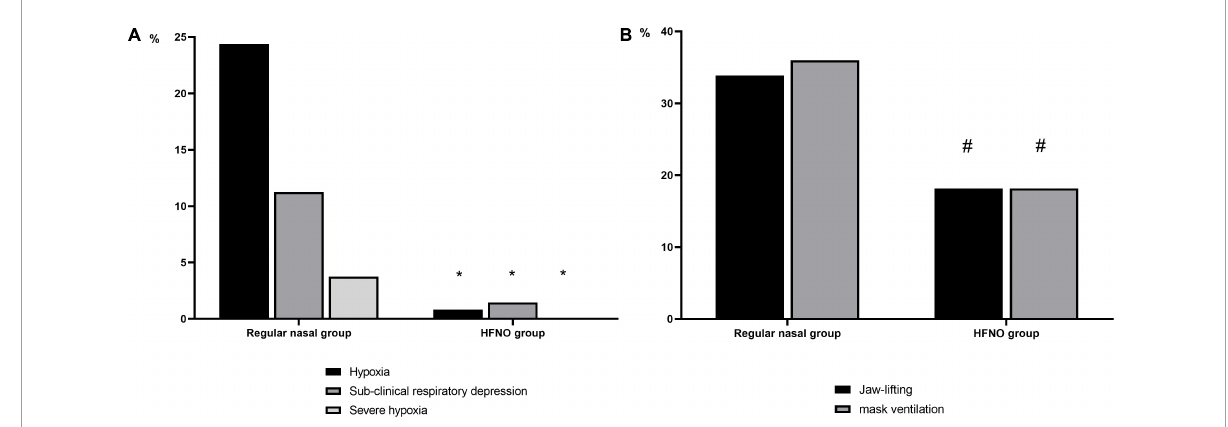
FIGURE3 Incidence of hypoxia events and their interventions. (A) Incidence of hypoxia events in both groups. Compared with the regular nasal group, HFNO significantly decreased the incidence of hypoxia (75% ≤ SpO2 < 90%, < 60 s), subclinical respiratory depression (90% ≤ SpO 2 < 95%) and severe hypoxia (SpO 2 < 75% for any duration or 75% ≤ SpO 2 < 90% for ≥ 60 s) from 24.38 to 0.83%, from 11.25 to 1.46% and from 3.75 to 0% (* P < 0.001, respectively). (B) Interventions during hypoxia. Compared with the regular nasal group, lower proportion in the HFNO group required oxygen improvement by jaw lifting or mask ventilation. In the regular nasal group, 132 patients needed their airway opened to relieve hypoxia, accounting for approximately 70% (69.84%) of the 189 patients; of these, 64 (33.86%) required jaw lifting and 68 (35.98%) required mask ventilation. However, in the HFNO group, only two patients required jaw lifting and two needed mask ventilation, which, respectively, accounted for 18.18% ( # P < 0.001, respectively). No patients were intubated in either